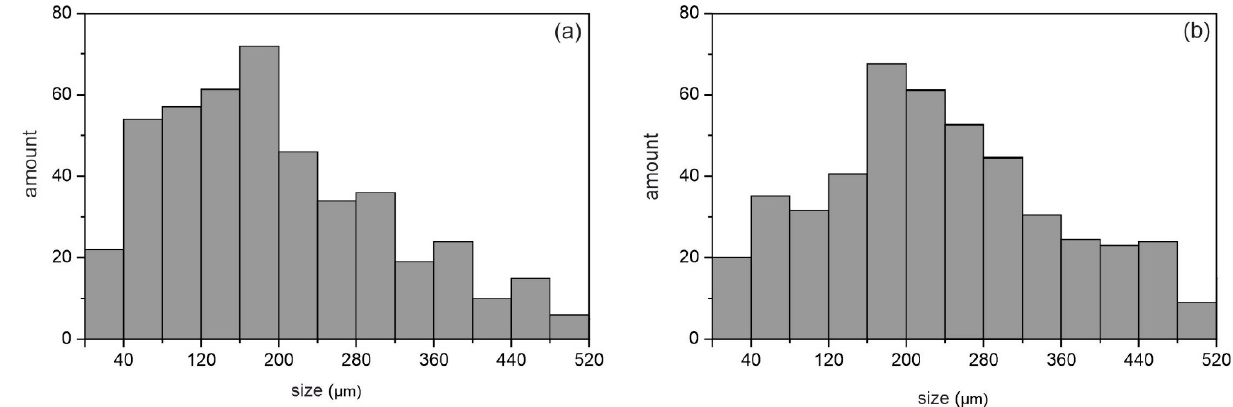
Figure 3. Pore size distribution histogram of porous NiTi-(Ar) ( a ) and NiTi-(N) ( b ) alloys obtained by the SHS.